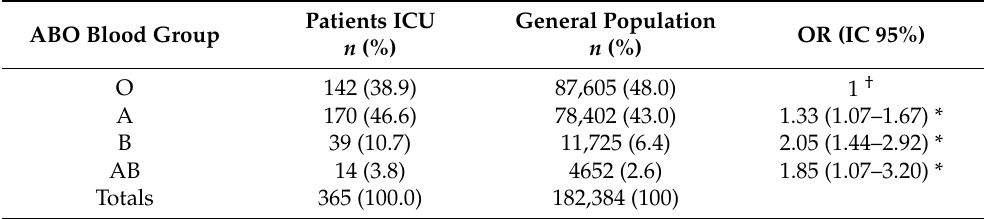
Table 3. Comparison between ABO group distribution in patients with COVID-19 admitted to the intensive care unit (patients ICU) and control group: general population. * p < 0.05.